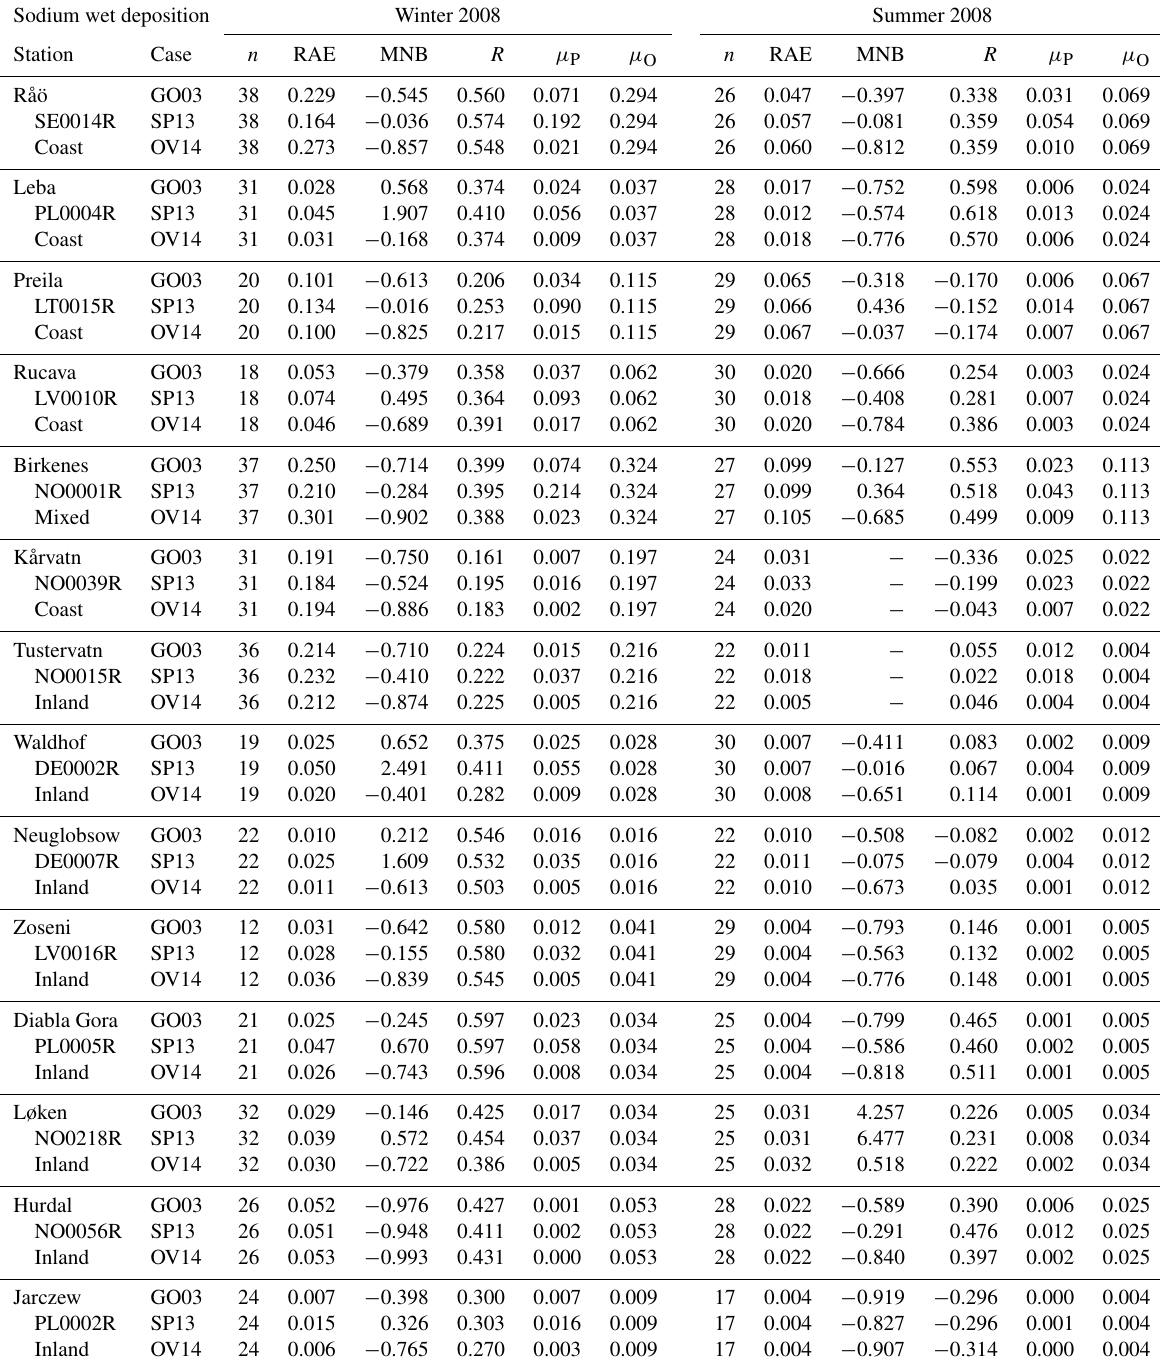
Table 5. Statistical metrics on modeled and measured sodium wet deposition at 14 EMEP stations. RAE, MNB, R , µ P (mean predicted), and µ O (mean observed) are